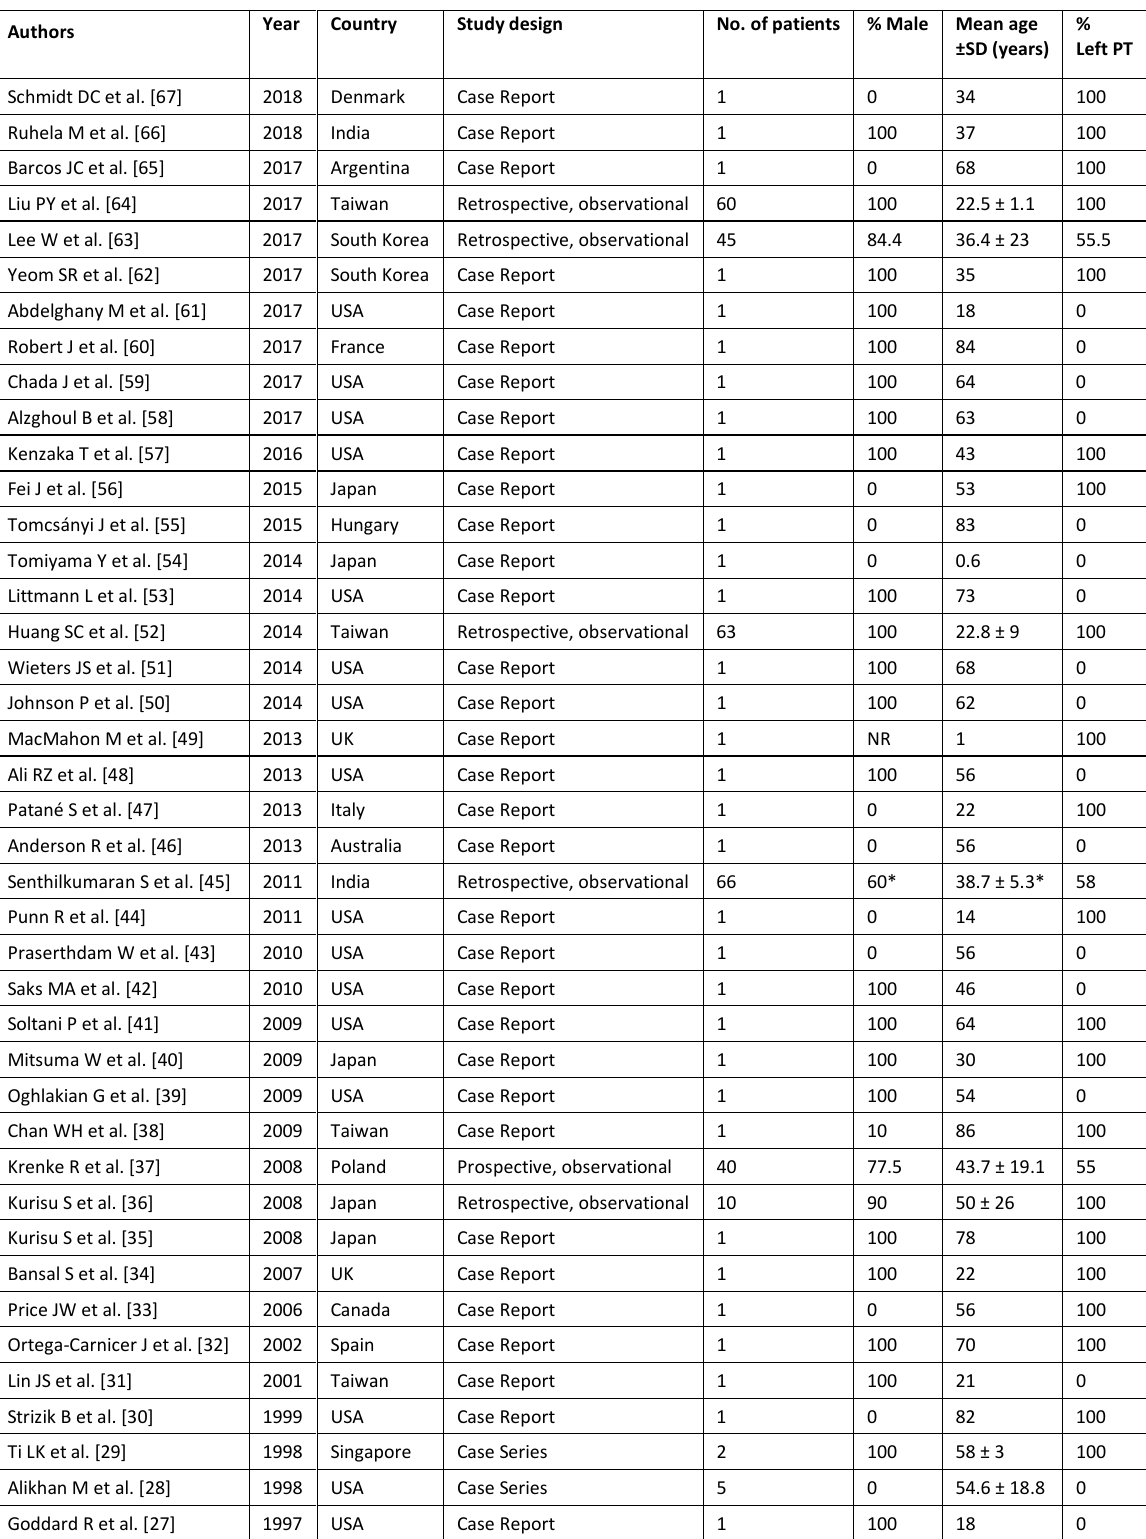
Table A1: Characteristics of selected